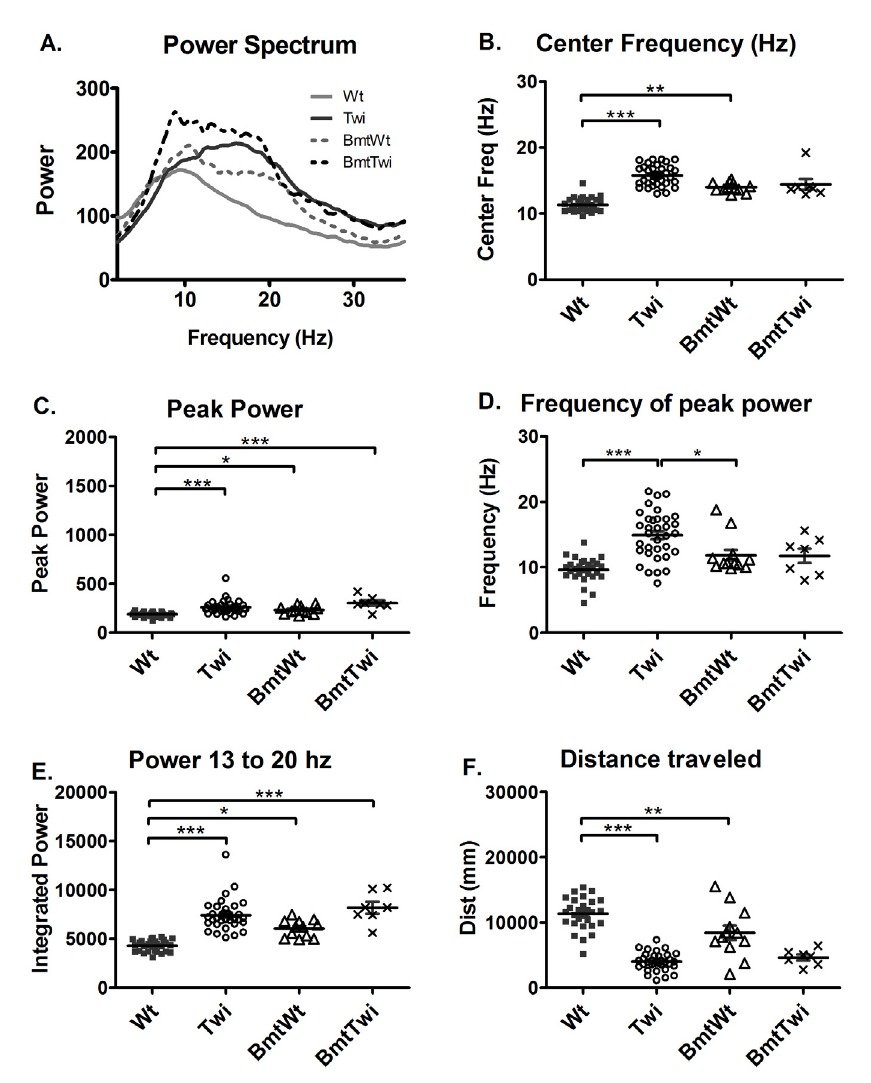
Figure 4. Effect of BMT on power spectra. The averaged power spectrum ( A ) of the BmtWt group (dashed gray line) is shifted upward and rightward compared to the Wt group (solid gray line). Similarly, the averaged power spectrum in the BmtTwi group (dashed black line) is shifted upward across a broad frequency band compared to the Twi group (solid black line). The center frequency ( B ) was significantly increased in the BmtWt group (open triangles) compared to the Wt group (filled squares). There was no significant difference between the untreated mut (open circles) and BmtTwi groups (cross marks) in the center frequency. The peak power ( C ), frequency of peak power ( D ) and the power between 13 and 20 Hz ( E ) was significantly increased in the BmtWt group compared to the Wt group. Compared to the Twi group, the BmtTwi group showed no significant difference in the center frequency ( B ), peak power ( C ), frequency of peak power ( D ) and power between 13 and 20 Hz ( E ). The distance traveled by the BmtWt group was significantly decreased compared to the Wt group ( F ). The horizontal bars represent the mean and the error bars represent SEM (*** p < 0.001, ** p < 0.01 and * p <